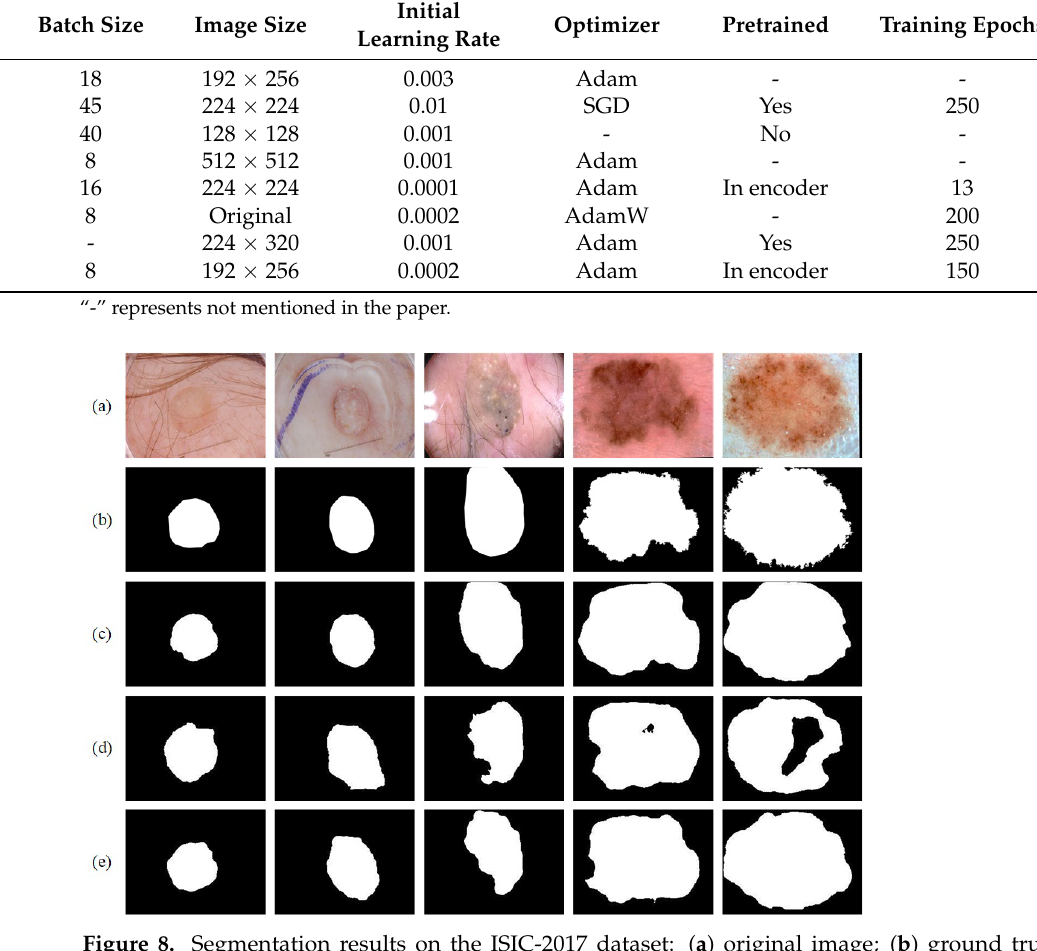
Figure 8. Segmentation results on the ISIC-2017 dataset: ( a ) original image; ( b ) ground truth; ( c ) segmentation result; ( d ) segmentation result of U-Net; ( e ) segmentation result of